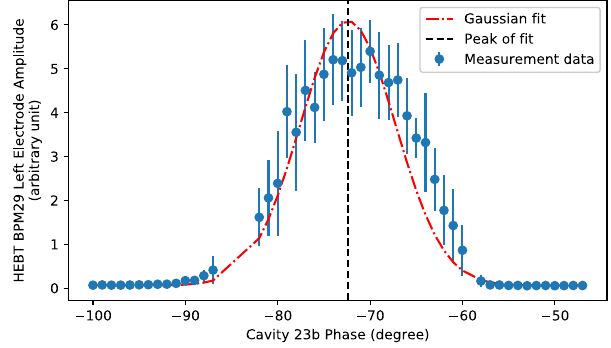
FIG. 2. Signal amplitude on the left electrode of the BPM downstream of the LACE study station versus rf phase of cavity 23b. Signal amplitudes are corrected using Eq. (12) to account for the effects of changing vertical beam size during the scan. Measurement data for cavity phases from − 86 ° to − 83 ° were lost due to data logging issues.